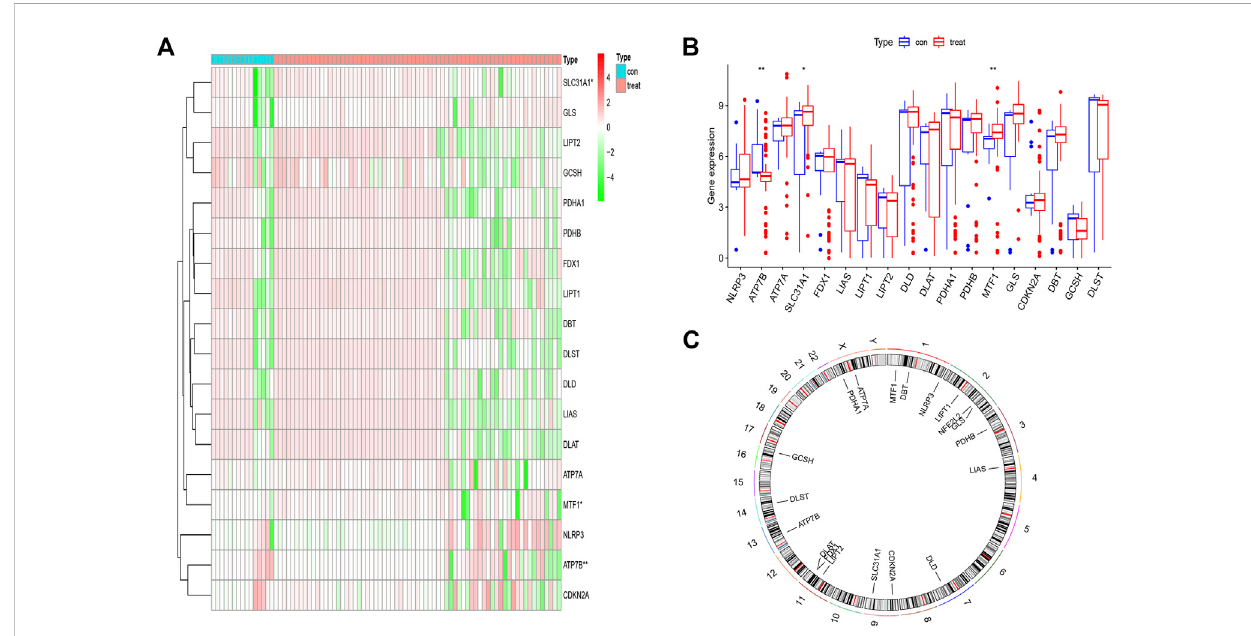
FIGURE 1 The landscape of the cuproptosis-related genes in psoriasis. (A,B) Expression heat map of the 21 m6A-related regulators in non-psoriasis and psoriasis patients. (C) Chromosomal positions of the 19 cuproptosis-related genes. * p < 0.05, ** p < 0.01, and *** p <